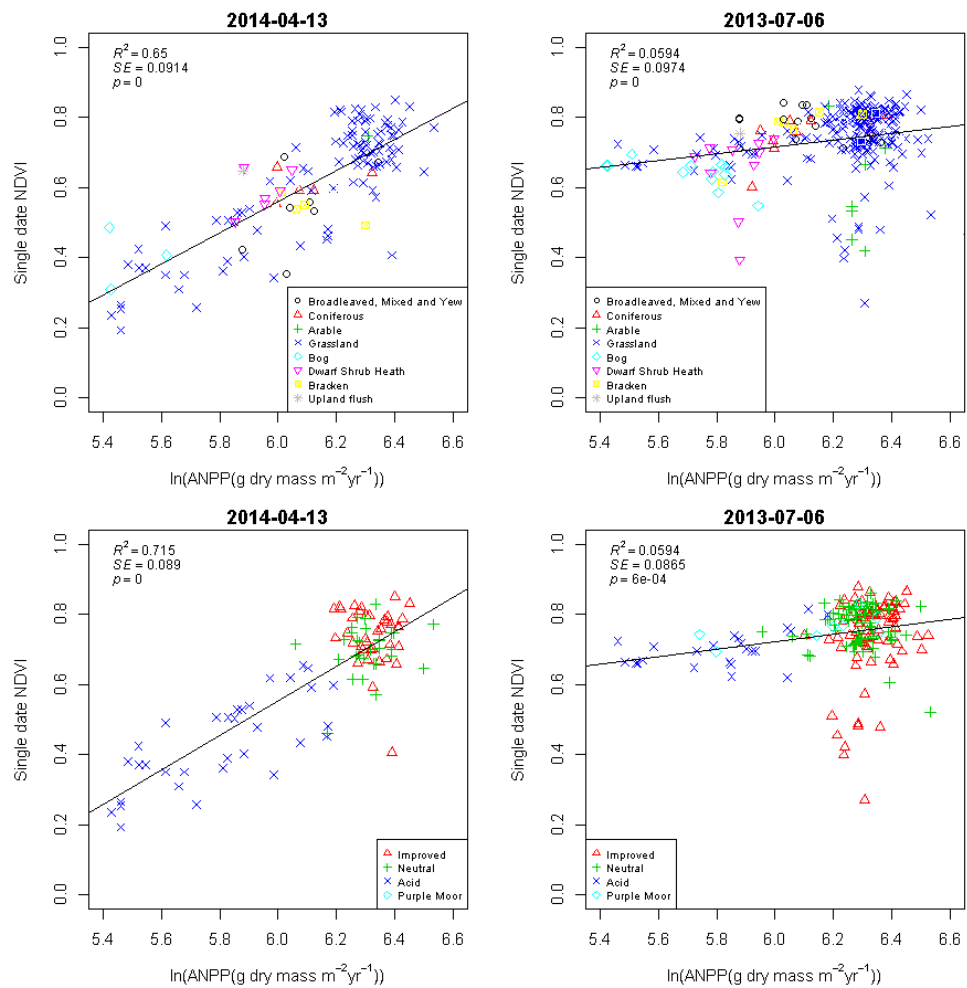
Figure 3. Scatter plots of Landsat 8 NDVI versus ln(ANPP) for all habitat types for: a spring image ( top left ); and a summer image ( top right ); and for grassland habitats in: spring ( bottom left ); and summer ( bottom right ).